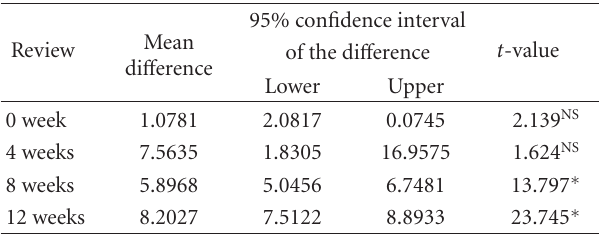
Table 3: Comparison of WOMAC function mean score between group A and group B.